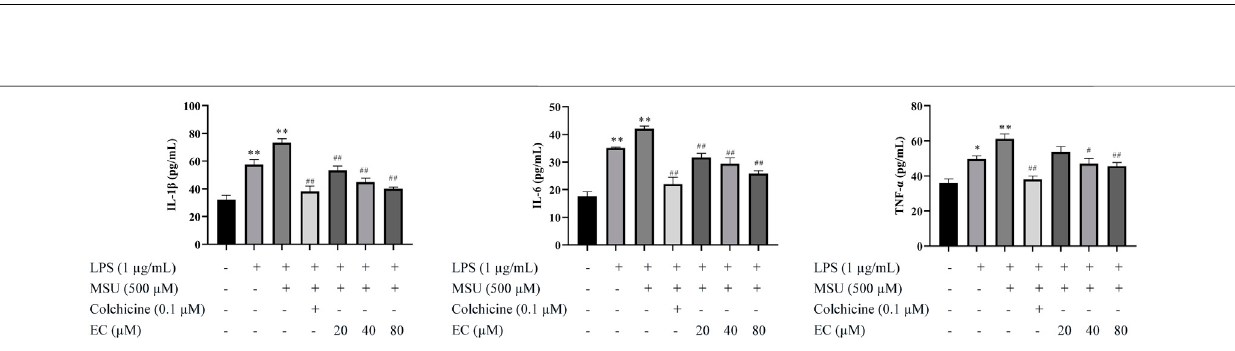
FIGURE2| Levels ofIL-1 β ,IL-6, and TNF- α inTHP-1 cell supernatants.After PMA(50 ng/ml) induction for 48 h and LPS(1 μ g/ml)pre-stimulation for24 h, THP-1 cells were pretreated with or without colchicine or various concentrations of EC for 0.5 h followed by MSU (500 μ M) stimulation for 23.5 h. Data are represented as mean ± SEM of three independent experiments. * p < 0.05 or ** p < 0.01 compared with the control group; # p < 0.05 or ## p < 0.01 compared with the LPS+MSU